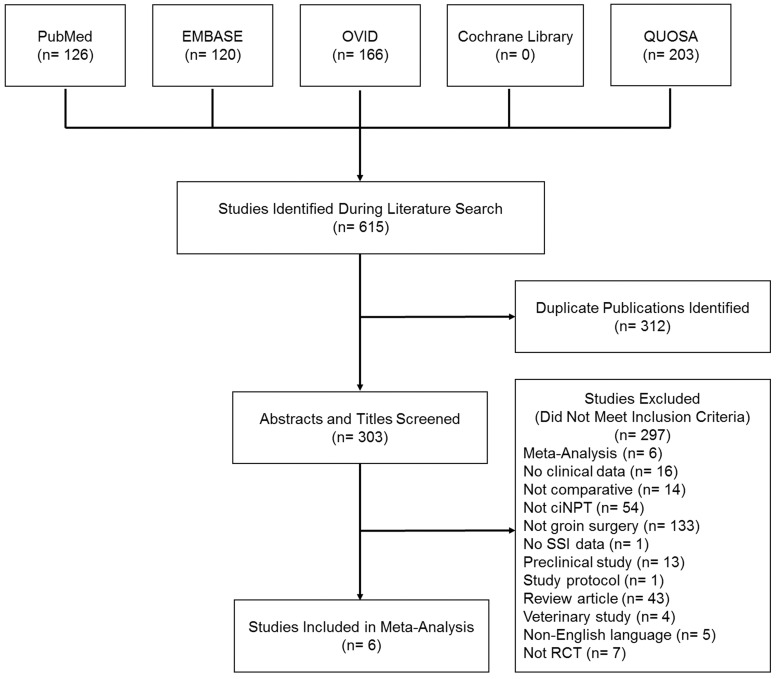
A PRISMA flowchart showing the process of identifying articles for inclusion in the systematic review and meta-analysis. ciNPT: closed incision negative pressure therapy; SSI: surgical site infection; RCT: randomized controlled trial.